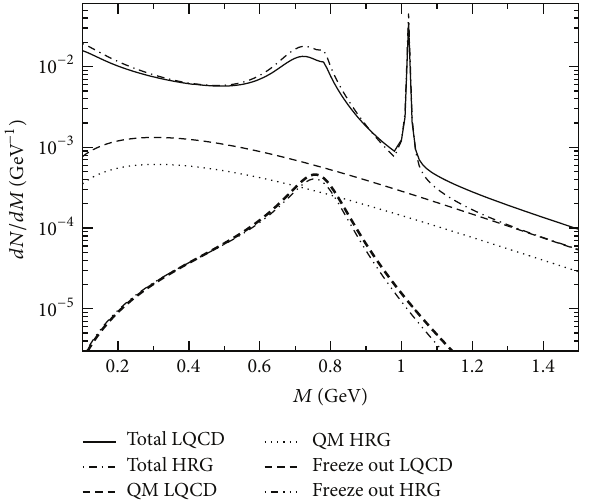
Figure 26: QGP and total contribution for EoS (a) HRG (dotted and dash-dotted lines) and EoS (b) LQCD (dashed and solid lines) at LHC